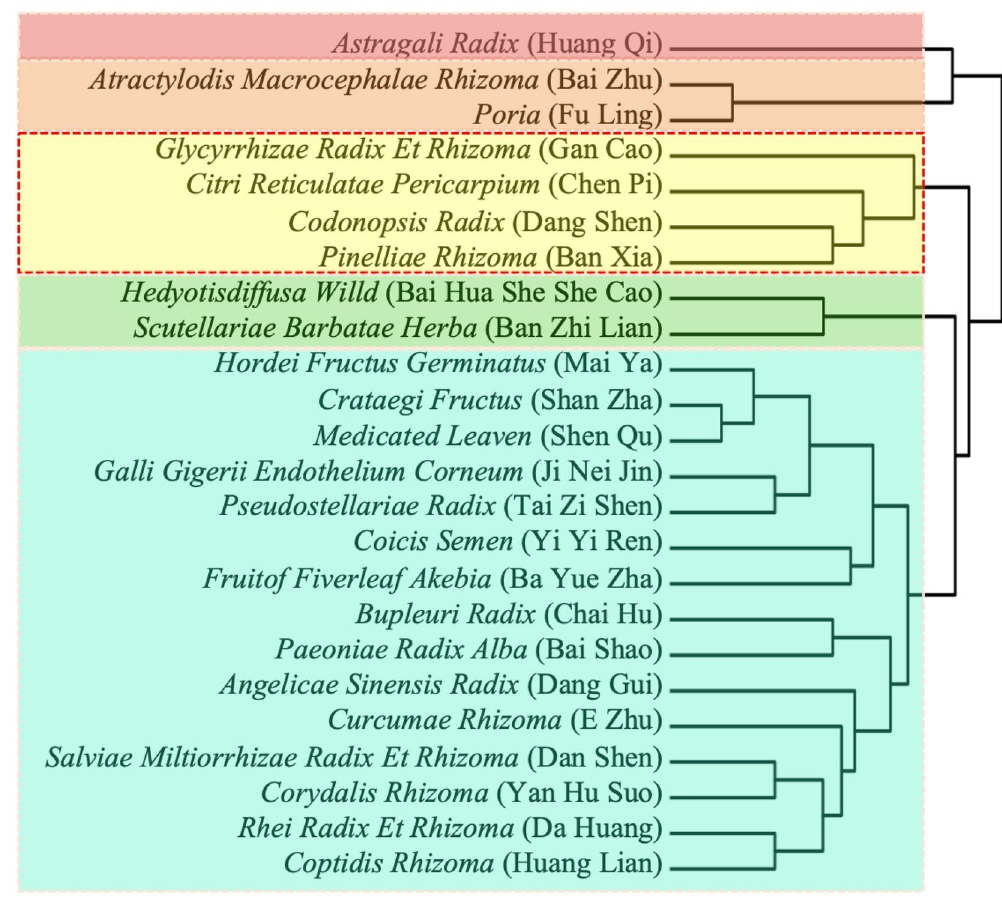
Figure 3. Unsupervised hierarchical cluster analysis of the 24 most frequently used herbs.